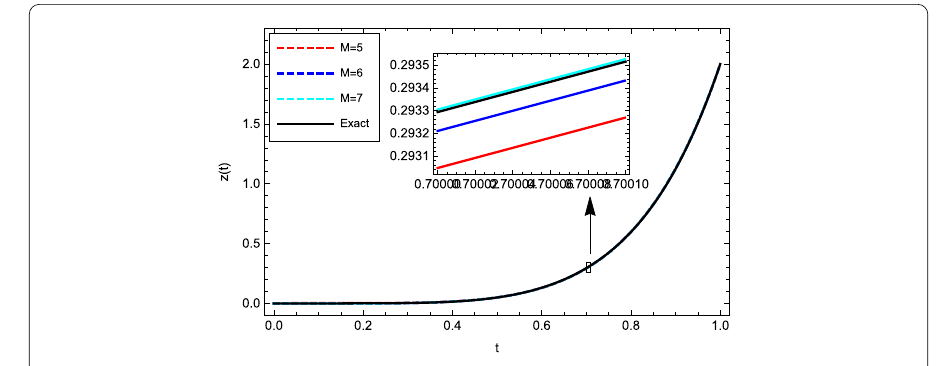
Figure 2 Numerical results obtained for Example 5.2